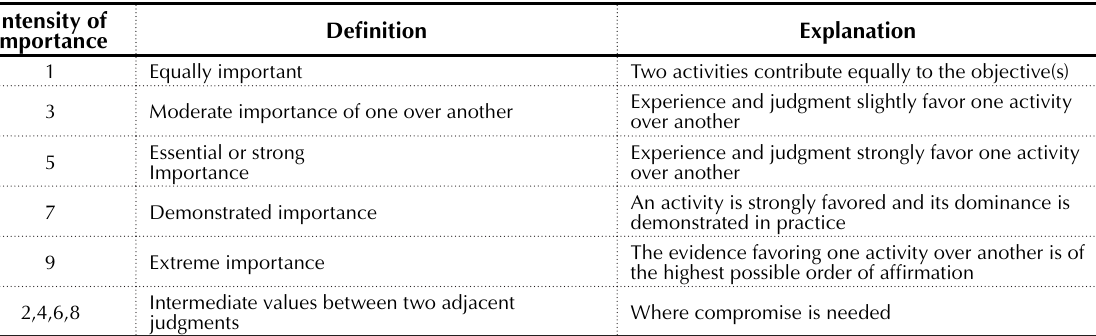
Table 1. Saaty’s scale